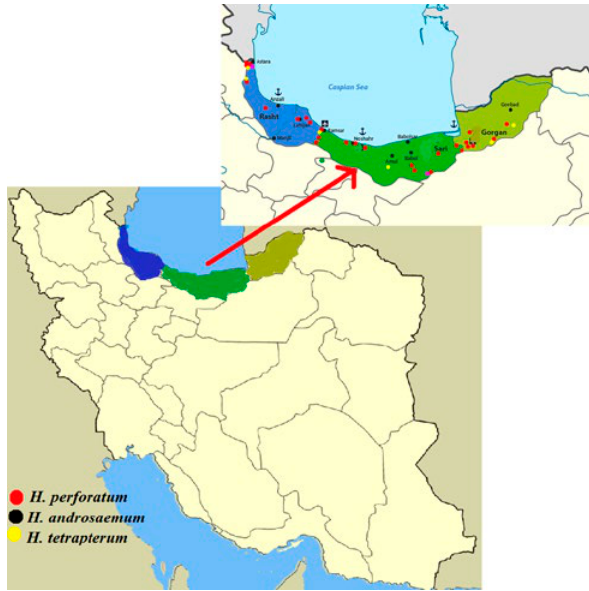
Figure 1. Distribution map of Hypericum populations